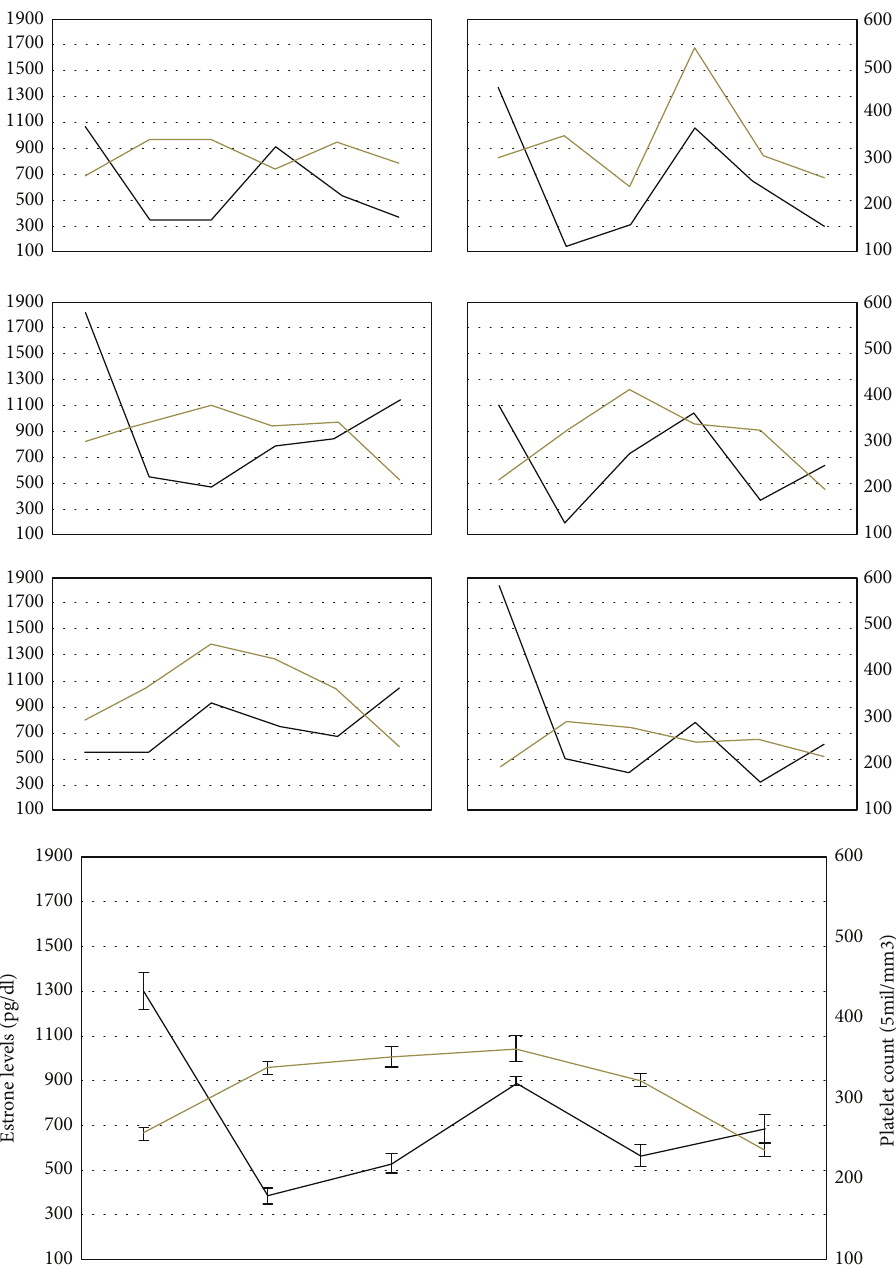
Figure 2: Estrone levels (black line) and platelet count (gray line) for each studied female (small graphs) and as an average of the six animals (bigger graph) in the samples collected during the baseline (BL) period and after each CHC administration. The x -axes of small graphs are the same as in the bigger graph. Error bars represent standard